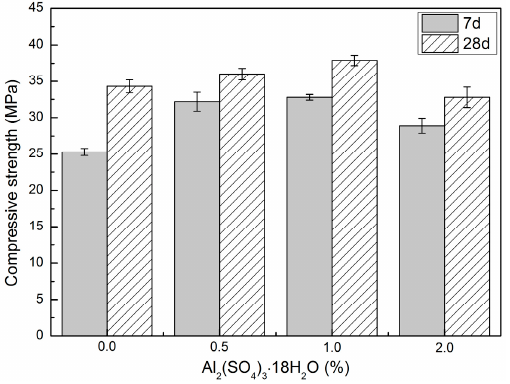
Figure 6. Effect of aluminum sulfate on the compressive strength of concrete.